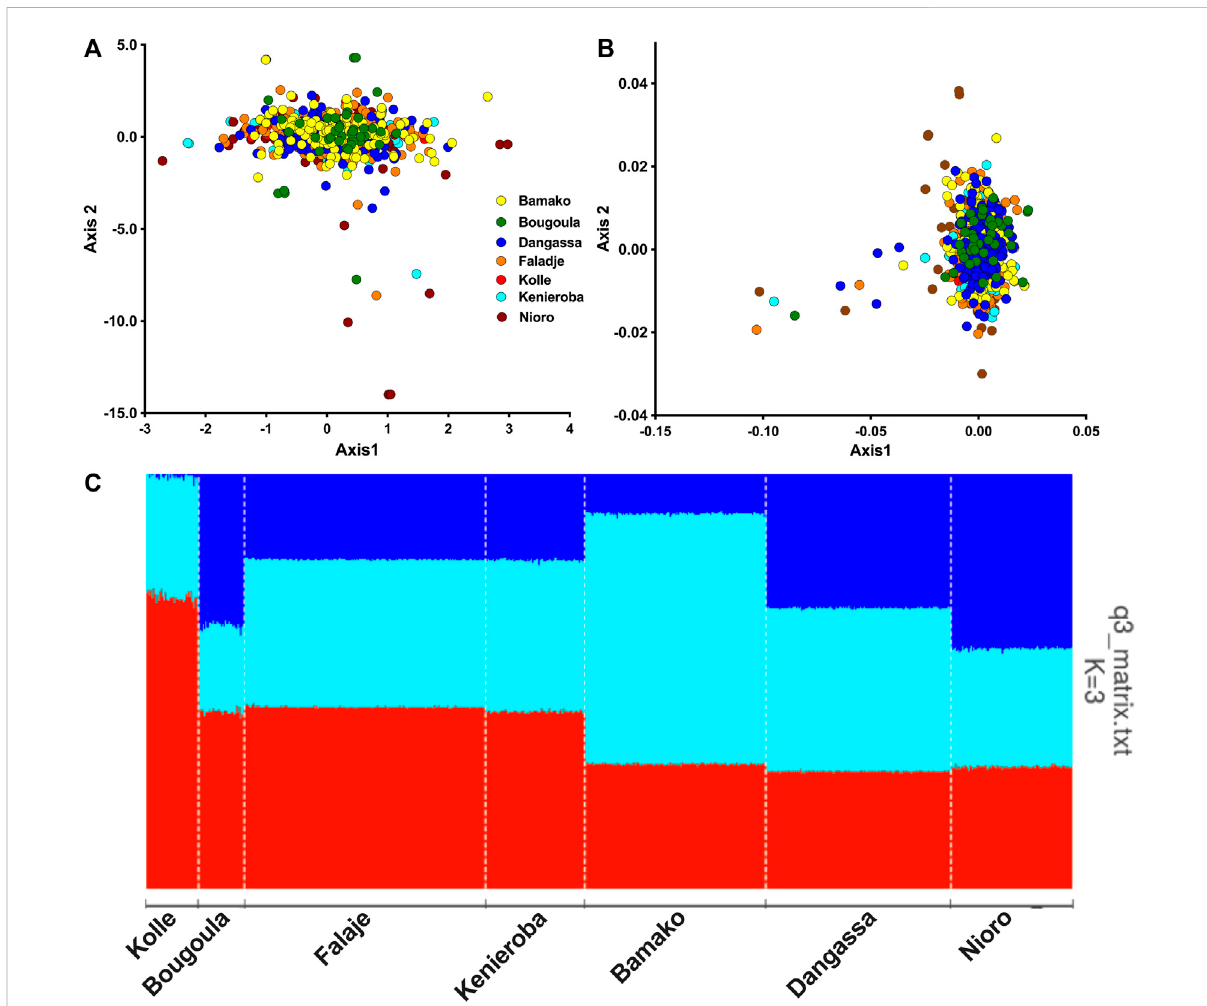
FIGURE 2 Population structure and ancestry of P. falciparum from Mali. (A) Plot of the fi rst two components (Axis1 vs . Axis2) of principal component analysis(PCA)usinggenotypedatafromsamplesinMali. (B) Scatterplotof fi rsttwodimensionsofmultidimensionalscaling(MDS)ofidentitybystate between pairs of isolates. Each point represents an isolate, color-coded by sites of sampling. (C) Barplot of ancestry proportions per sample and site of collection shown on the x -axis. Each ancestral population is indicated by a different color, (K1 (red), K2 (turquoise), and K3(blue)) and each vertical bar represents a single sample, colored according to the estimated ancestry